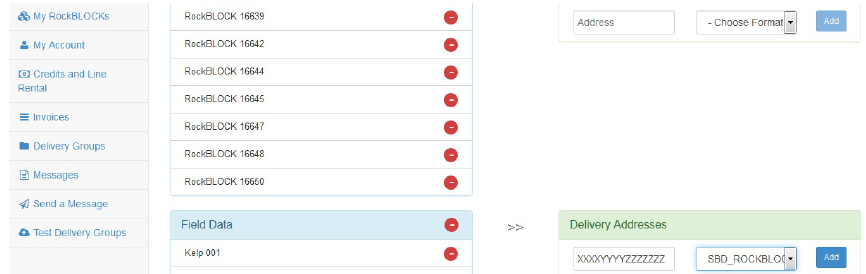
Figure A1. A screenshot of the ‘Delivery Group’ page on the Rock7 website (https://rockblock.rock7. com/Operations).